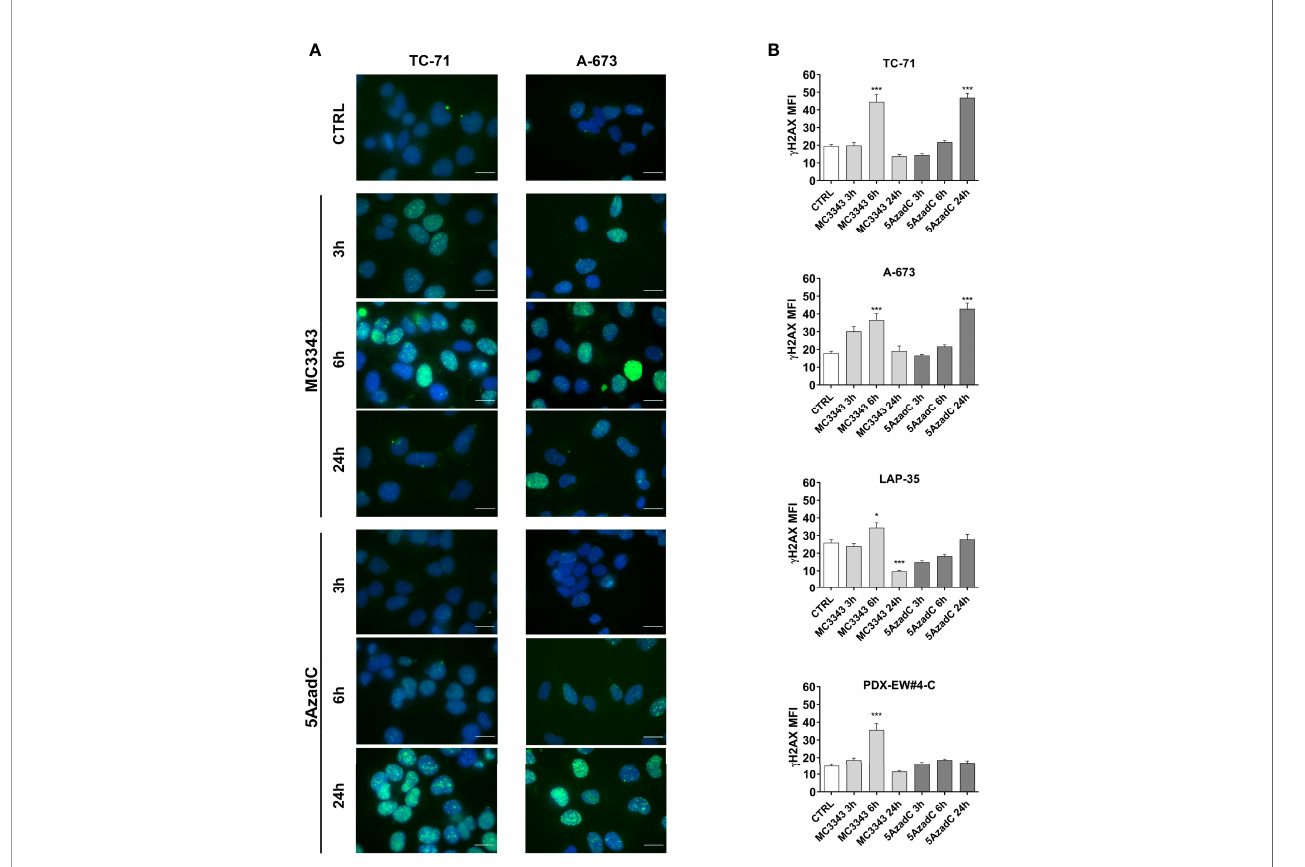
FIGURE 3 | MC3343 and 5azadC kinetics of DNA damage induction. (A) Merged immuno fl uorescence of TC-71 and A-673 staining for g H2AX (green) and DAPI (blue) after 3, 6 and 24h of treatment with DMSO, MC3343 or 5azadC. Digital images were acquired under identical conditions at the same time, using image analysis software (NIS Elements, Nikon). Representative images are shown. Scale bars, 20 µm. (B) DNA DSBs measured by levels of mean fl uorescence intensity (MFI) of g H2AX positive nuclei in at least 20 different fi elds for each condition. (*p < 0.05; ***p < 0.001, one-way ANOVA